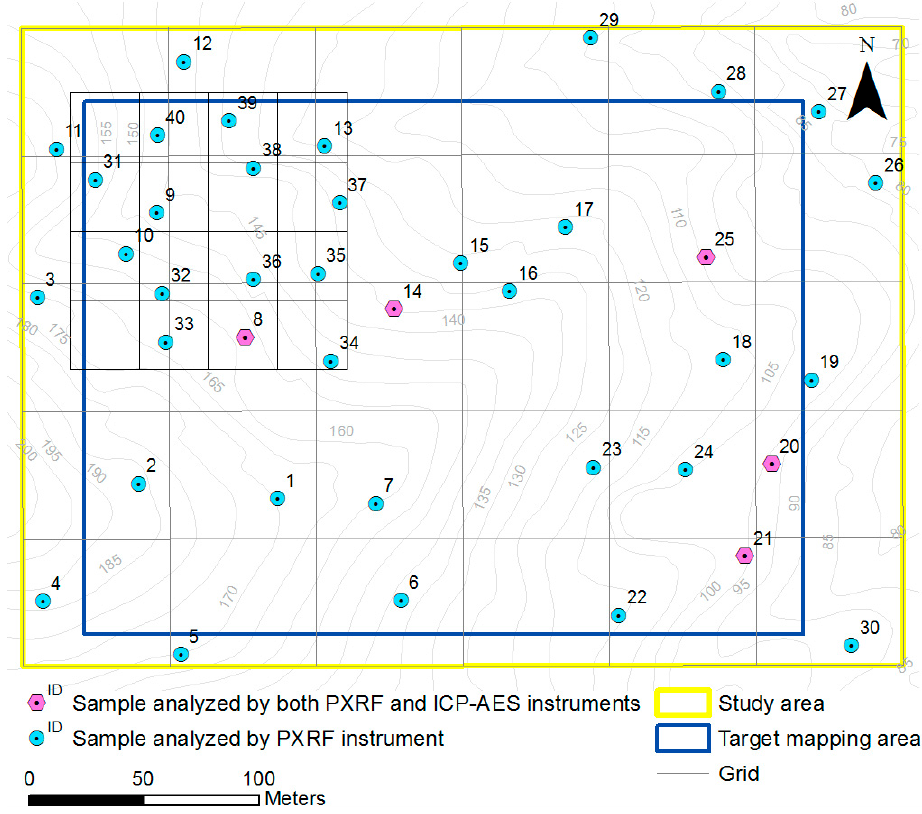
Figure 2. Sampling points for soil contamination survey using portable X-ray fluorescence (PXRF) and inductively coupled plasma atomic emission spectrometry (ICP-AES).